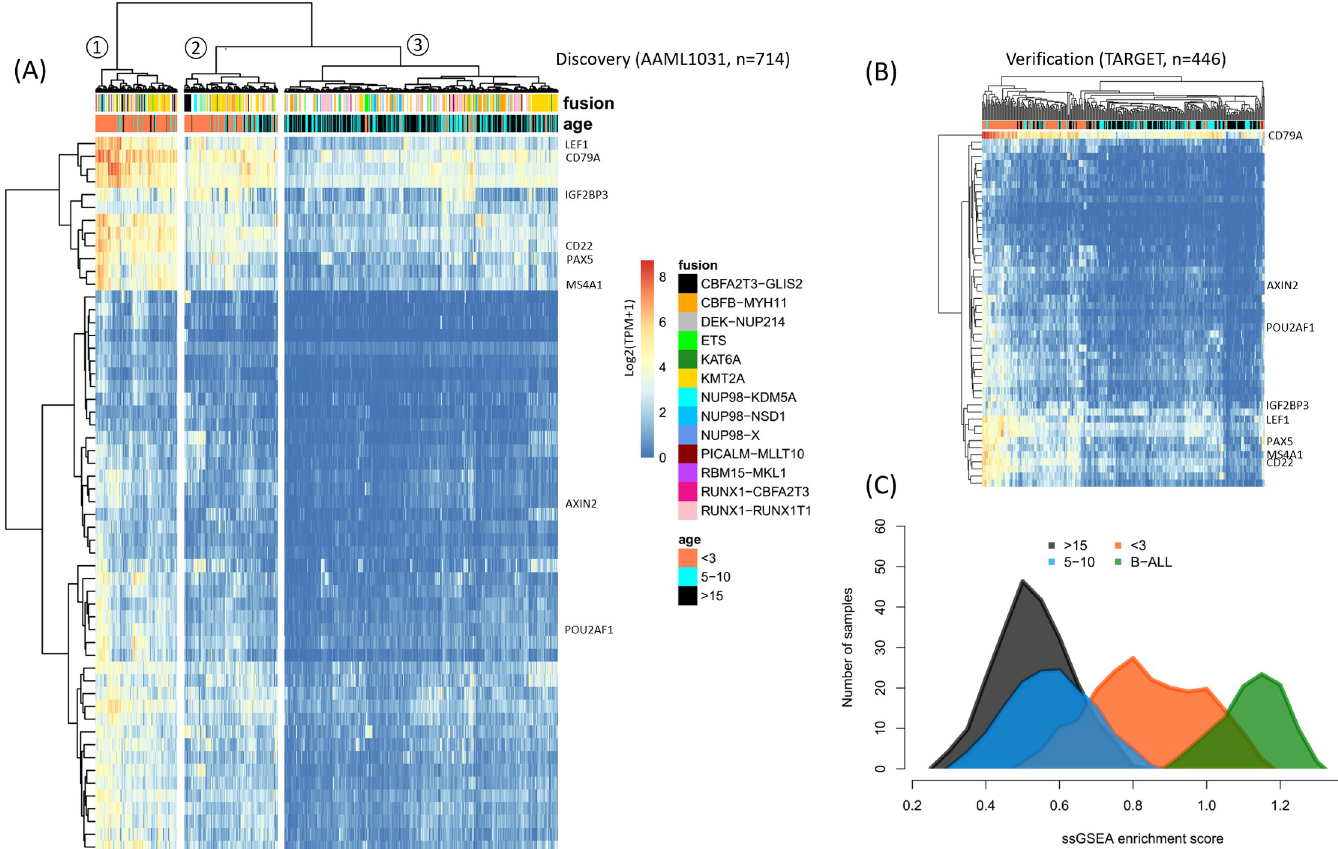
Fig 3. A group of 56 genes (51 of which are B-cell associated) clusters pediatric AML by age. ( A ) Heatmap showing unsupervised hierarchical clustering using Euclidian distance of log2(TPM+1) values and “ward.D2” clustering (n = 714 patients falling within the age-groups shown). Genes of special note are underlined in red. Age groups and translocations (fusions) are indicated in the annotation rows at the top. ( B ) Unsupervised hierarchical clustering in an independent cohort of 446 pediatric AML patients produces a similar pattern of clustering by age groups. ( C ) Single Sample Gene Set Enrichment Analysis (ssGSEA) enrichment scores (horizontal axis) using the 56 genes in (A) suggests the expression pattern of these genes in infant AML is highly-similar–but not identical–to B-ALL from the NCI TARGET project.